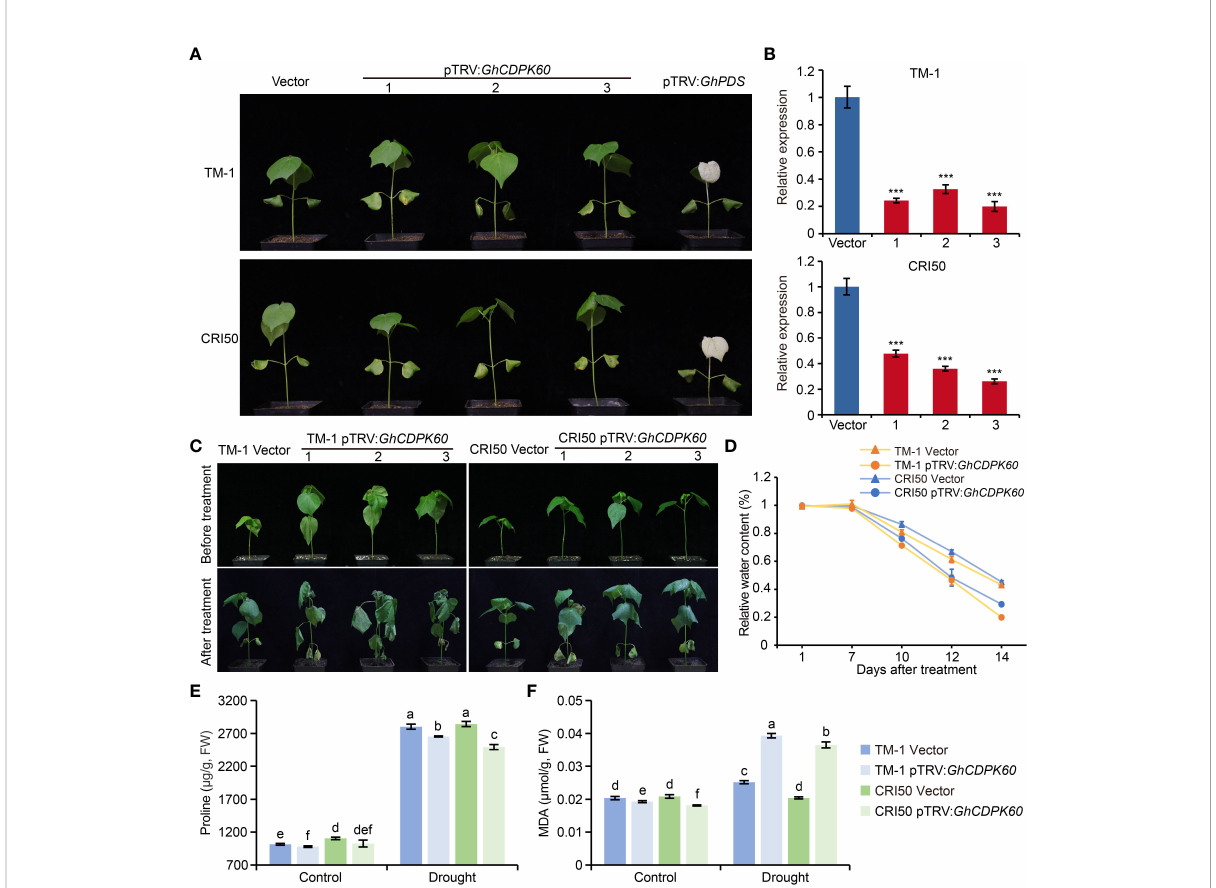
FIGURE 5 Silencing of GhCDPK60 decreased tolerance to drought stress in cotton plants. (A) Phenotypes of control (lines infected with empty vector) and GhCDPK60 -silenced plants in two different species of cotton. The GhPDS gene was used as an indicator with an albino phenotype on leave after VIGS in cotton. 1-3 indicated three individual plants. (B) Relative expression levels of GhCDPK60 in vector and pTRV : GhCDPK60 plants. (C) Phenotypes of drought-stressed control and GhCDPK60 -silenced plants in two different species of cotton. Photographs were taken before treatment and two weeks after drought treatment, respectively. (D) Relative water content of control and GhCDPK60 -silenced plants under drought treatment. (E, F) The analysis of proline (E) and MDA (F) content in control and GhCDPK60 -silenced plants leaves after drought treatment. Values represent the mean ± SE from three biological replicates. *** P < 0.001 by Student ’ s t test. Columns with different letters indicate signi fi cant differences ( P < 0.05, Student ’ s t